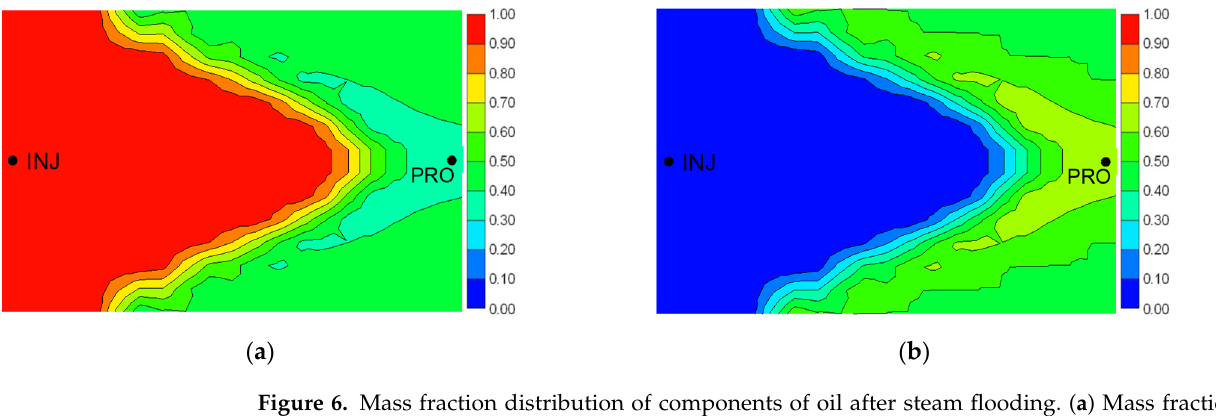
Figure 7. Cumulative oil production after steam flooding at different proportion of components. Time (Date) C u m u l a t i ve O il S C ( m 3 )